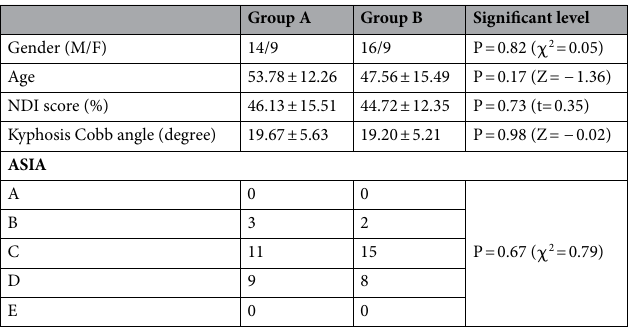
Table 1. Preoperative patients dermographic data for traction group and non-traction group. NDI neck disability index score, M male, F female, ASIA American spinal injury association impairment